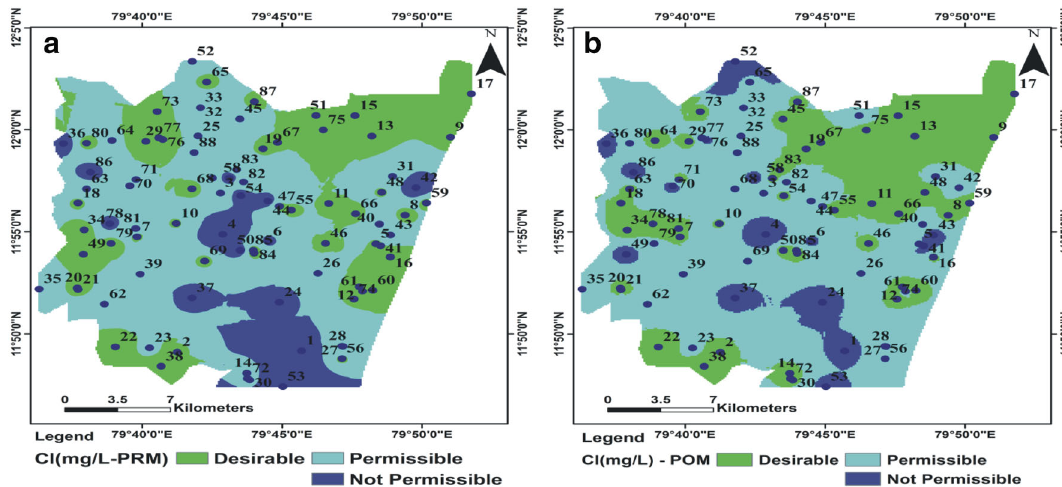
Fig. 10 a , b Spatial distribution map of Cl (pre- and